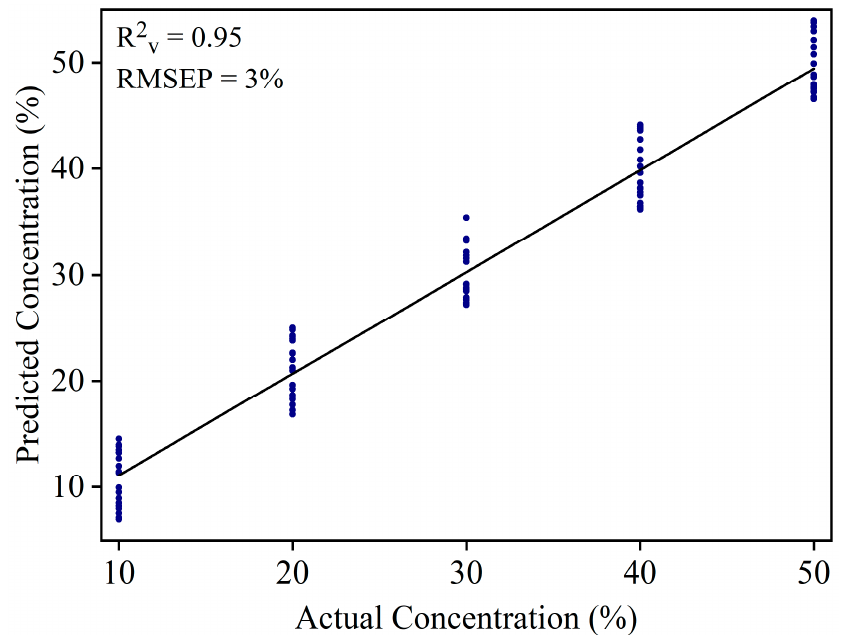
Figure 6. Validation result of the PLSR model of white turmeric samples at 10% to 50% concentrations.